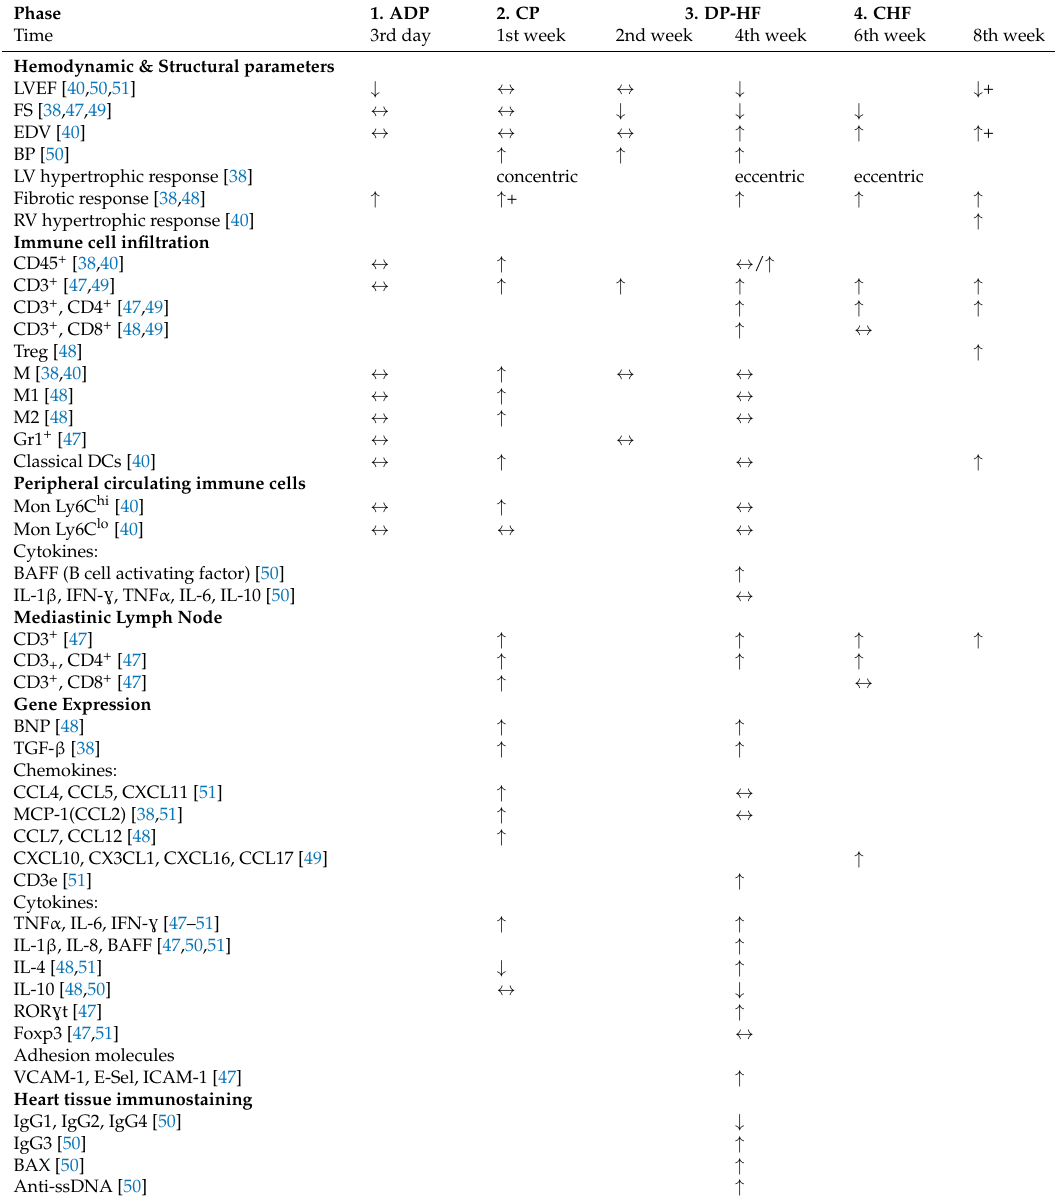
Table 2. Detailed description of known parameters in